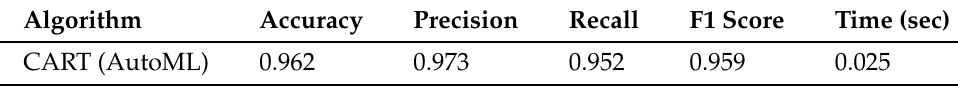
Table 4. Results using the AutoML optimized